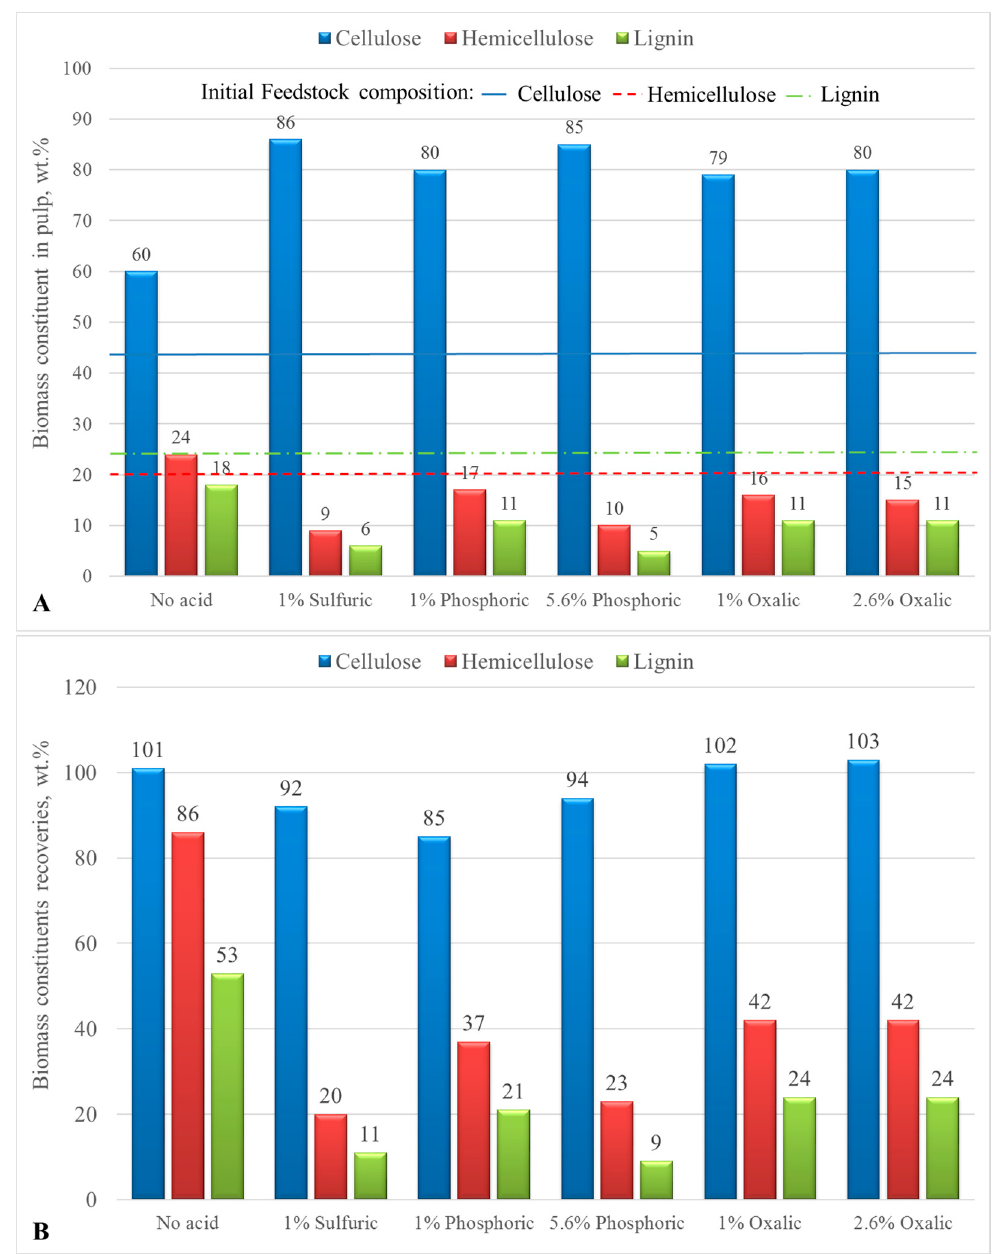
Figure 2. Pulp compositions ( A ) and biomass constituents recoveries ( B ) in solid pulps in batch autoclave runs at 175 °C, 1 h reaction time, LSR = 10, effect of homogeneous catalysis, data labels have been rounded for clarity of presentation.